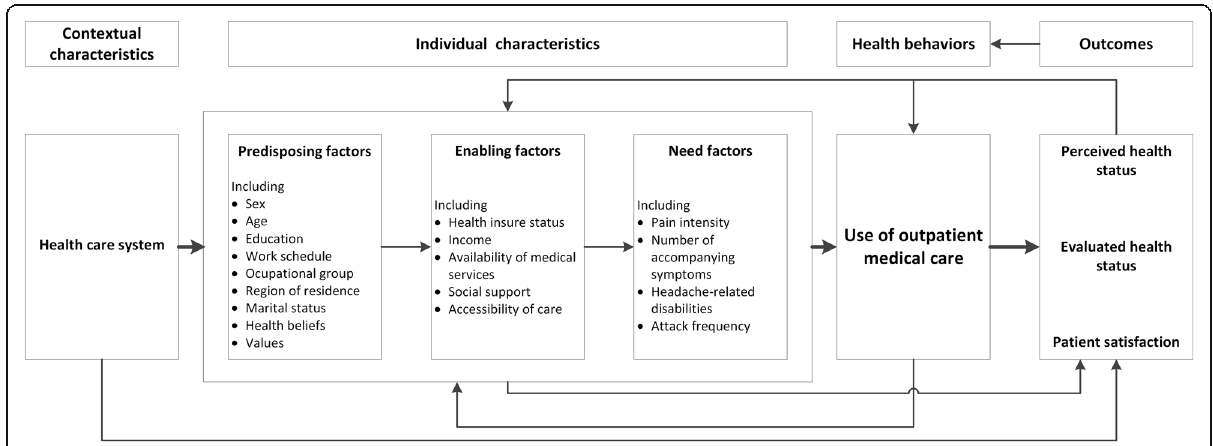
Fig. 1 Revised version of the Behavioral Model of Health Services Use: modified for persons with headache [5,